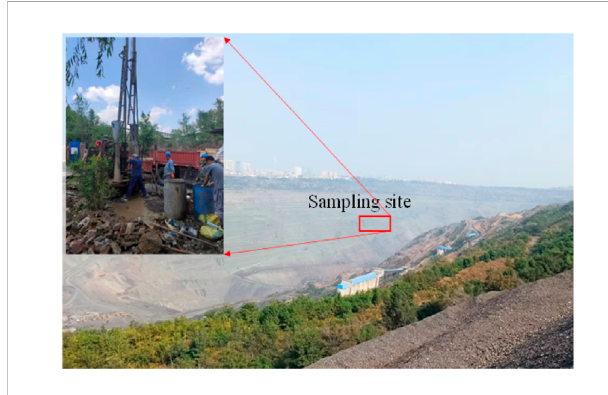
FIGURE 1 The overview of the Fushun west open pit slope and the sampling site.